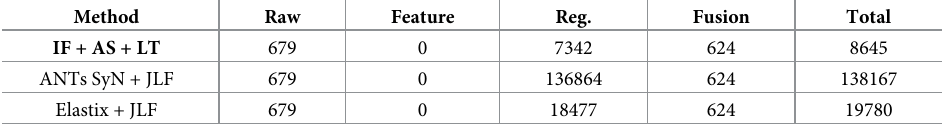
Table 6. Overall disk usage of three best-performing systems, measured in megabytes, based on our experiment on ADNI